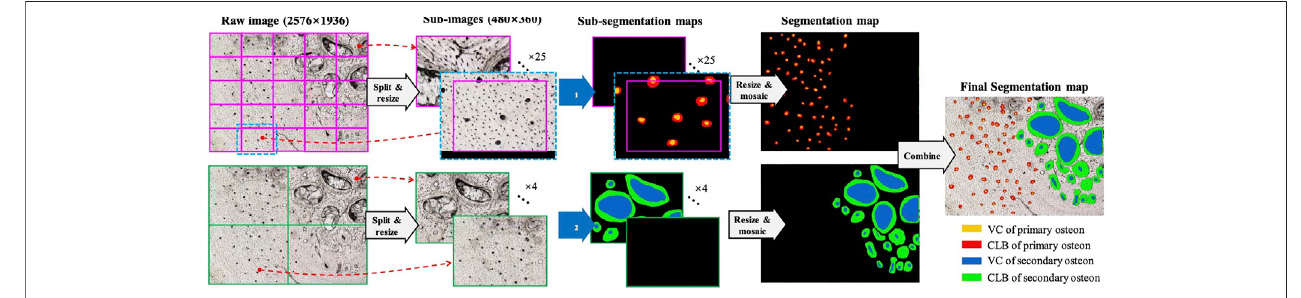
FIGURE 1 | Segmentation strategy for fossil osteon